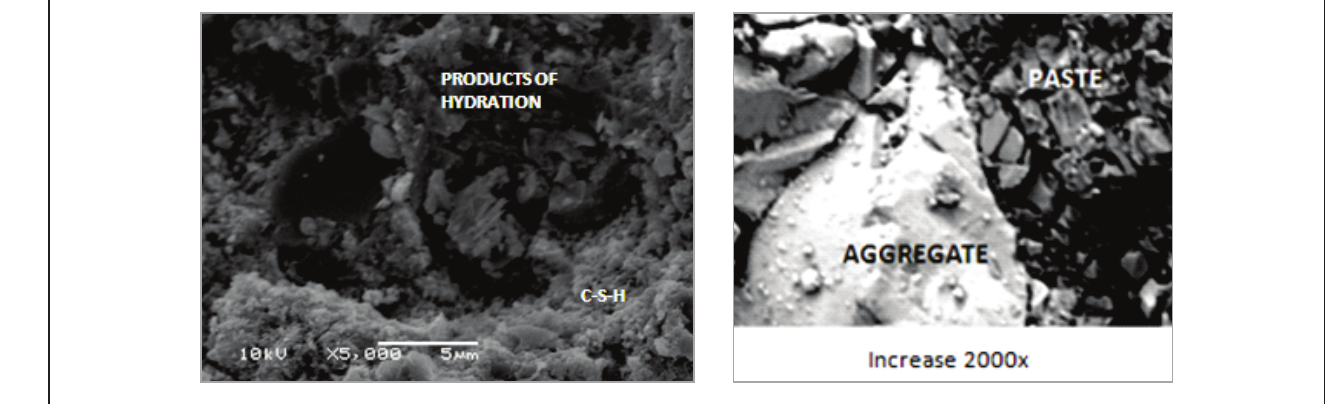
Figure 9 – Observations with MEV SE of mixture RCC1-FT